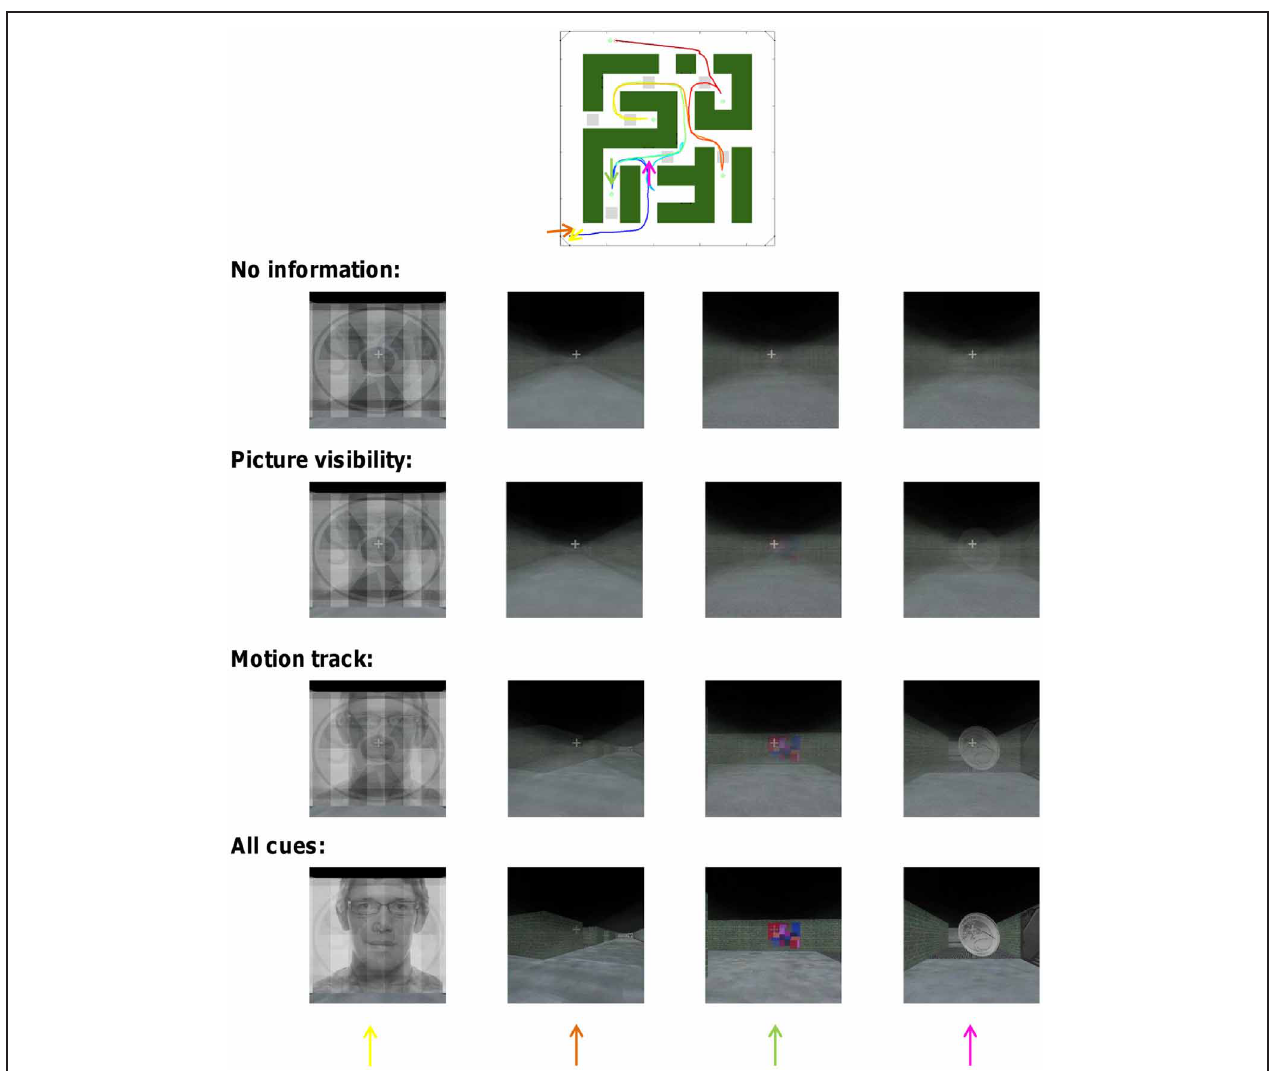
FIGURE 7 | Combinatorial decoding decreases the uncertainty about which track subjects have followed. The impact of decoding upon uncertainty is illustrated visually for one track by the degree of averaging visual scenes across multiple tracks. Four time points of the track are